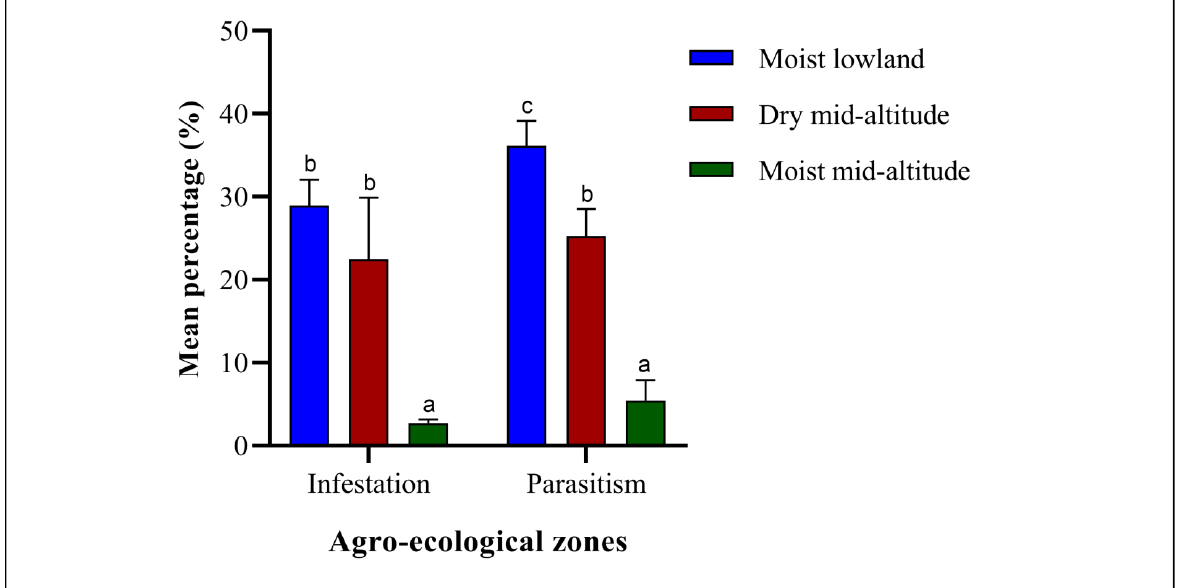
Figure 3: Percentage infestation and parasitism across different AEZ. Percentage infestation with same letters above the bars are not significantly different ( p >